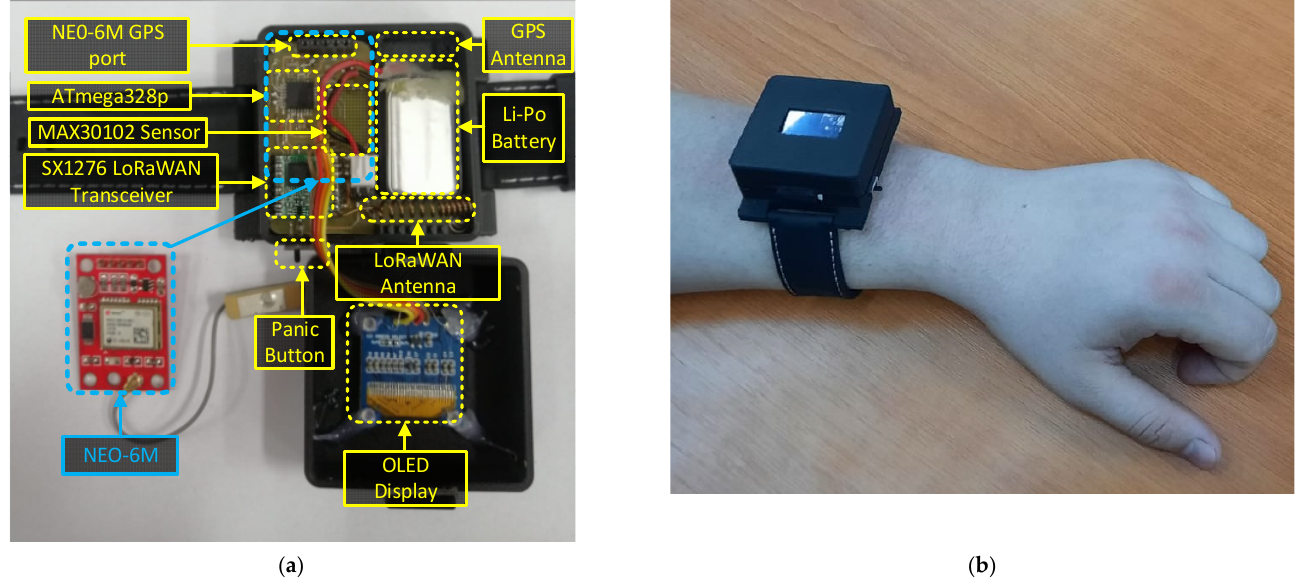
Figure 6. Physical implementation of the wearable device. ( a ) IoT multi sensor configuration. ( b ) IoT wearable device installed on patient.